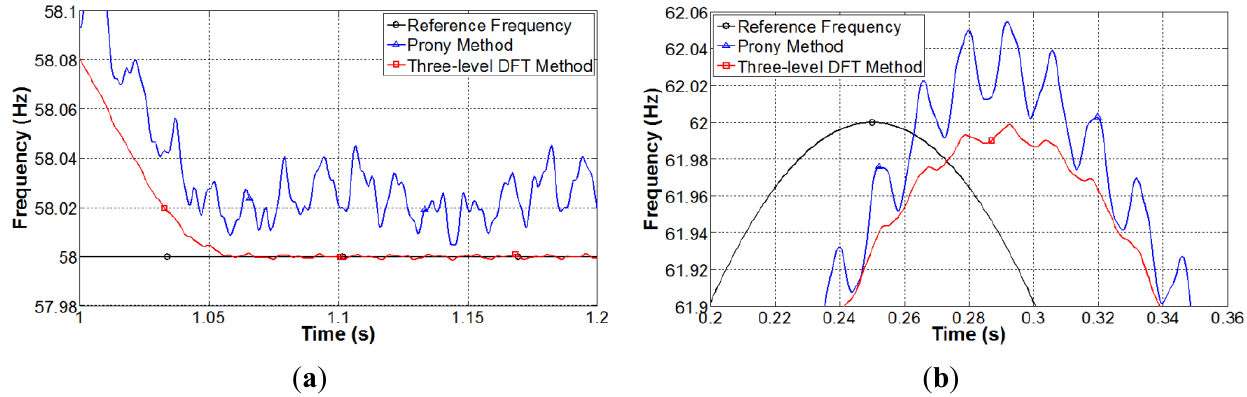
Figure 7. Estimation of ramp-down and sinusoidal frequency variations in the presence of harmonics and inter-harmonics. ( a ) Ramp-down frequency variation; ( b ) Sinusoidal frequency